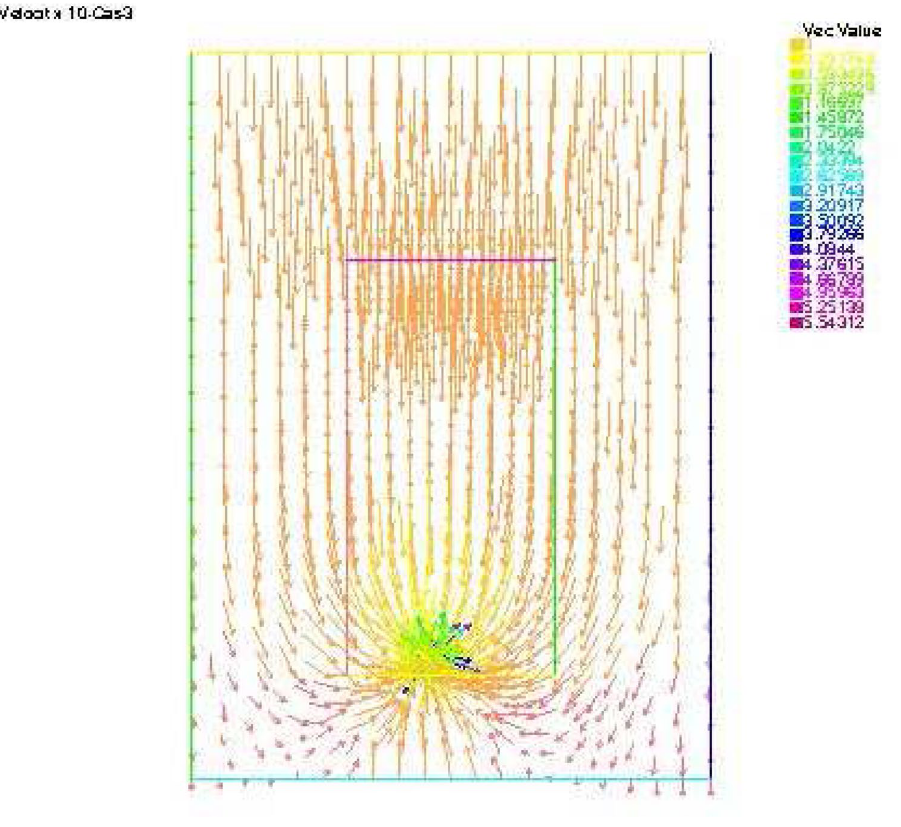
Figure 10. Velocity x 1e4—Case